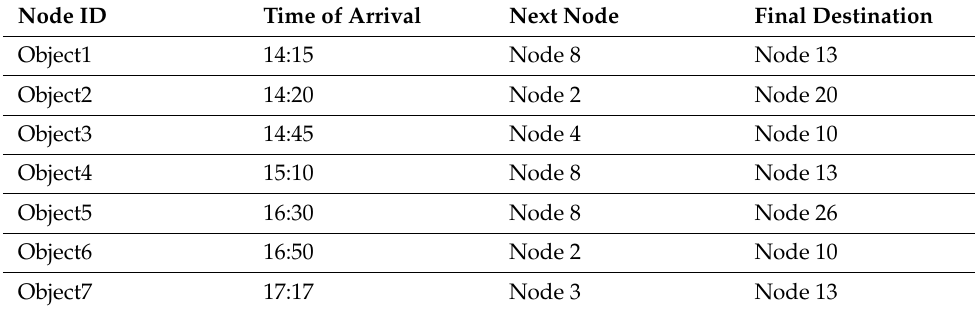
Table 1. Example of a record table of a sensor node (Assume the node ID is 10).